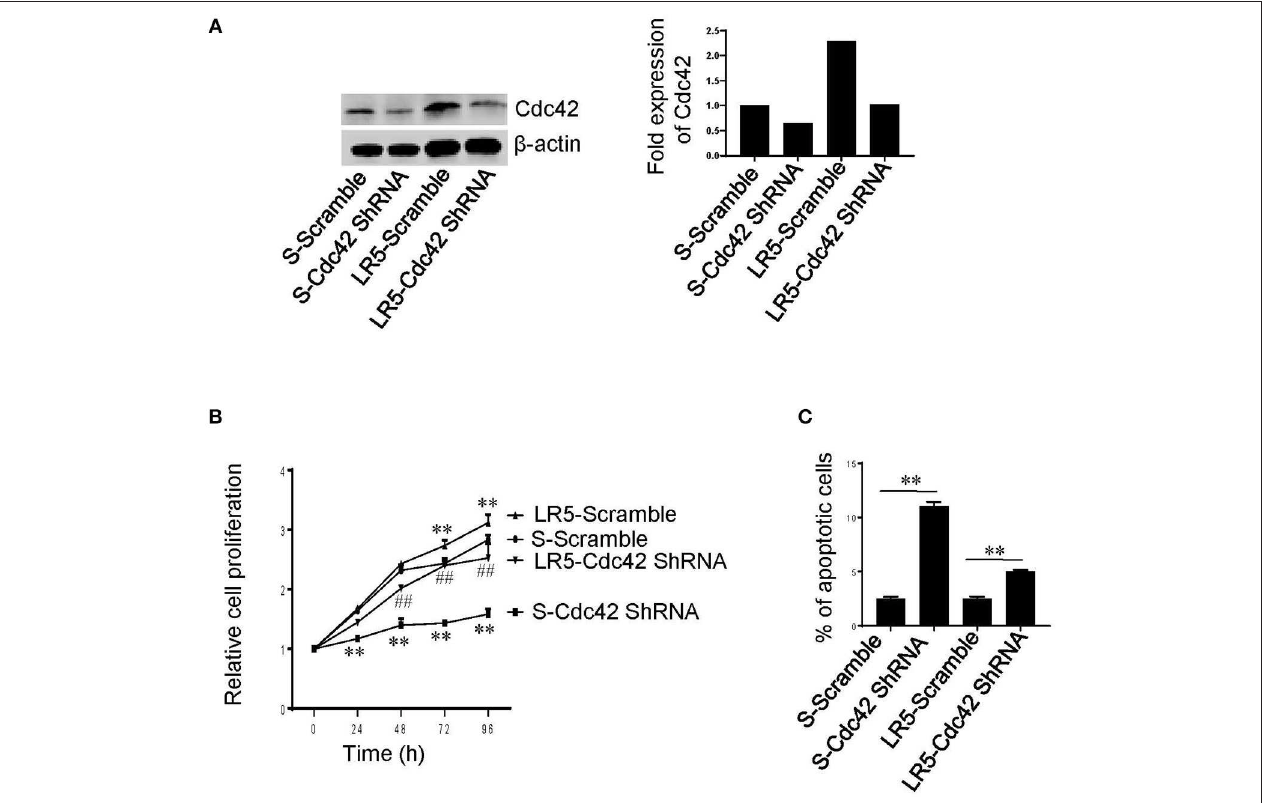
FIGURE 1 | Cdc42 knockdown inhibits proliferation and causes apoptosis of MM cells. (A) Western blot analysis of Cdc42, following transduction of melphalan-sensitive (S) and melphalan-resistant (LR5) MM cells with Scramble shRNA (Scramble) or Cdc42 shRNA. β -actin was used as loading control (left). The expression levels of Cdc42 were quantified (right). (B) Proliferation of S and LR5 cells. ** P < 0.01 vs. S-Scramble; ## P < 0.01 vs. LR5-Scramble. (C) Apoptosis of S and LR5 cells. Annexin V + cells were analyzed using flow cytometry. ** P < 0.01. Error bars represent means ± SD of triplicates and data are representative of three independent